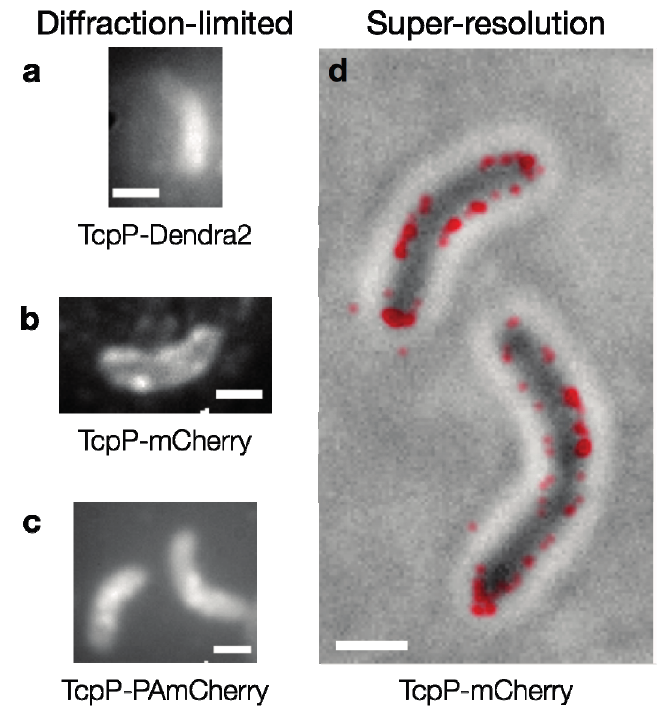
Figure 5. Fluorescent proteins in V. cholerae cells. Diffraction-limited fluorescence images of cells expressing ( a ) TcpP-Dendra2; ( b ) TcpP-mCherry and ( c ) TcpP-PAmCherry. Individual TcpP-Dendra2 molecules are not observed, and the cells in ( a ) are dimmer than those in ( b ) and ( c ). Bright foci are seen in the cells expressing TcpP-mCherry and TcpP-PAmCherry ( b , c ). Image acquisition times: 2–5 s; ( d ) TcpP-mCherry localizes to the cell membrane. Red: super-resolution image (based on 98 100-ms imaging frames) reconstructed from sequential localizations blurred to the 95% confidence intervals of each fit. This PALM image is plotted on top of a reverse-contrast bright field image of the cells (grey). Scale bars: 1